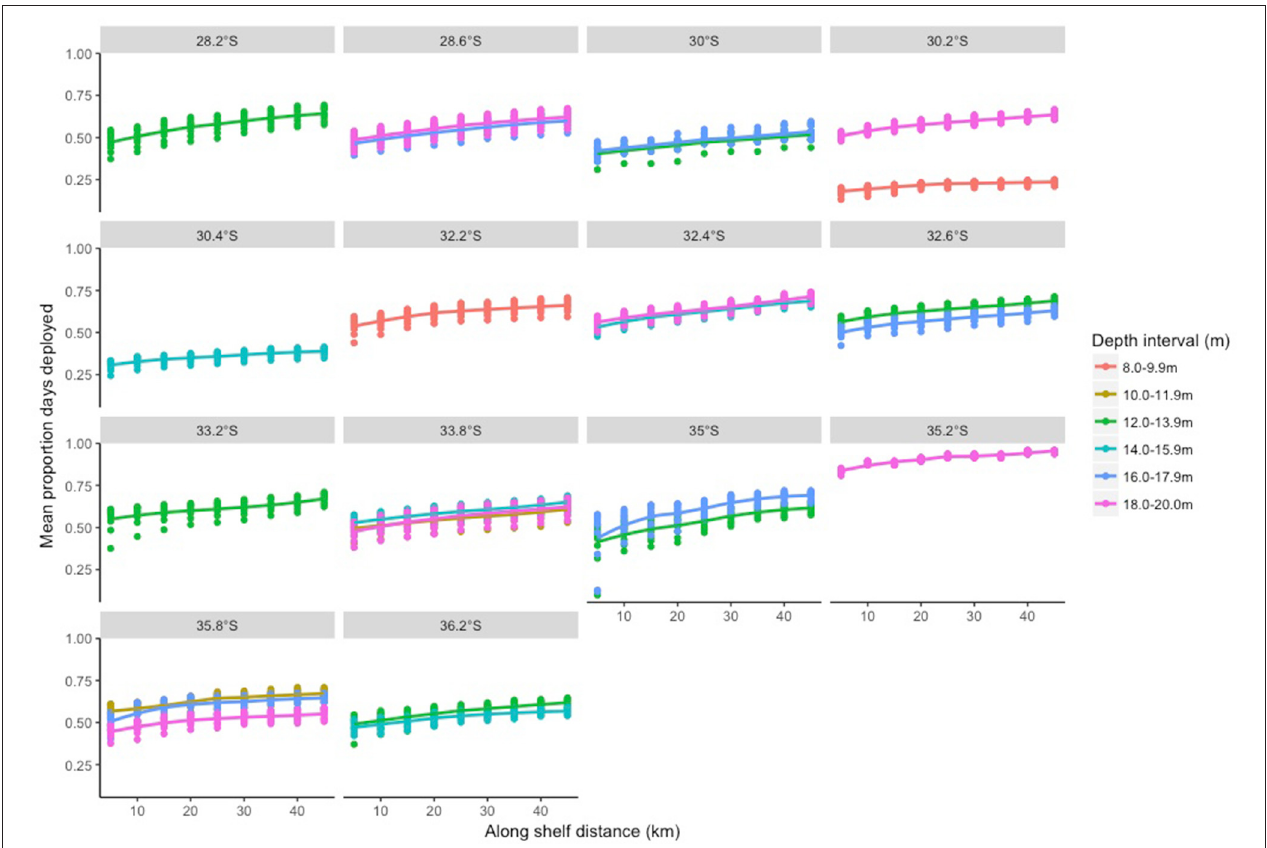
FIGURE 7 | Mean proportion of days that loggers were deployed that had corresponding satellite data for different along-shelf distances.